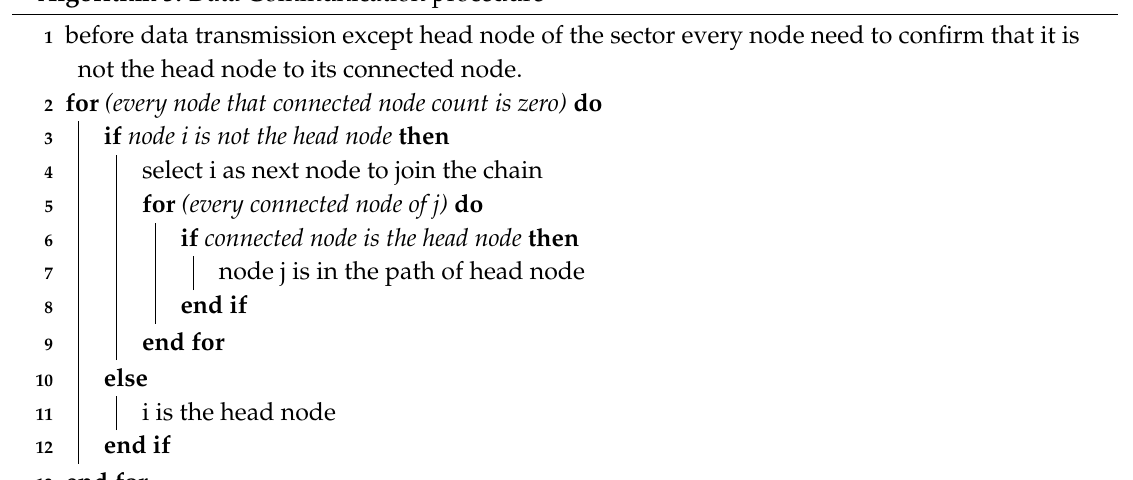
Algorithm 3: Data Communication procedure